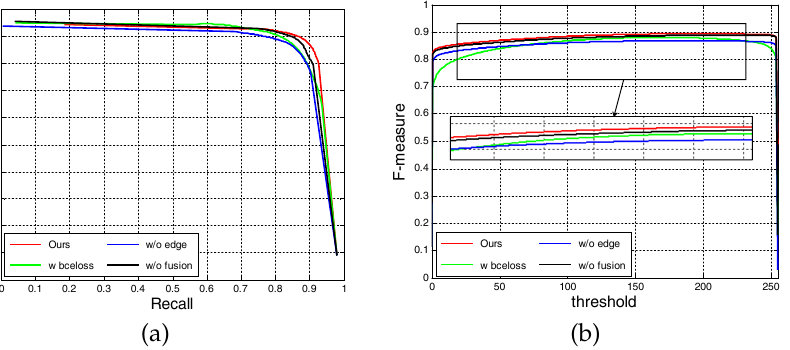
Figure 4. (better viewed in color) Quantitative evaluation of our network and ablation network: ( a ) P-R curves, and ( b ) F-measure curves.